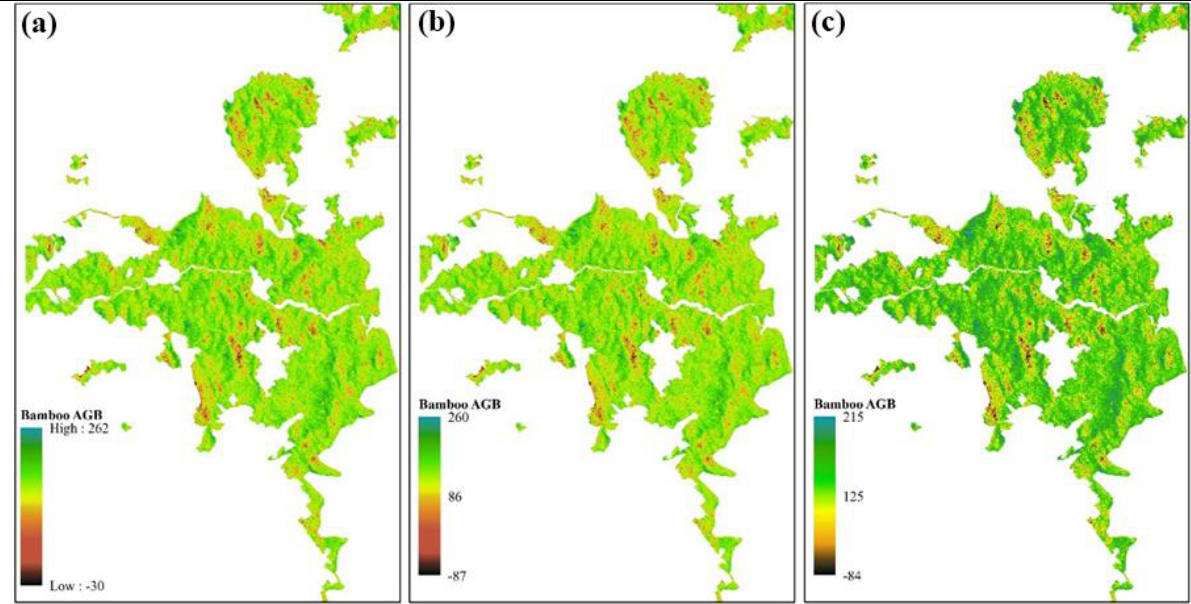
Figure 5. The predicted biomass using different models with sets of variables: (a) Red, (b) HV+EVI, and (c)